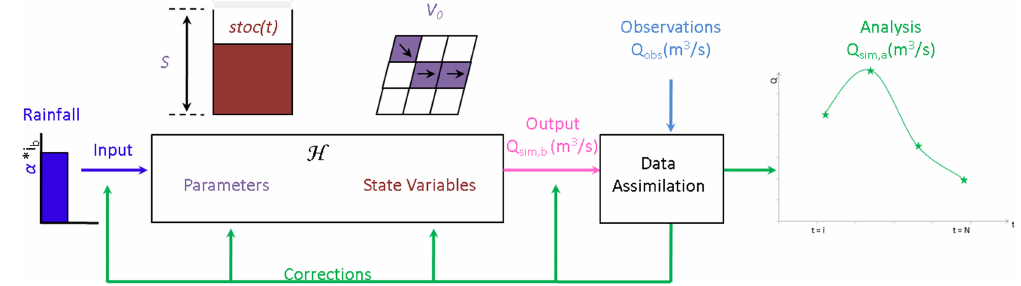
Fig. 4. Schematic representation of the hydrological model: inputs (blue), model parameters (purple), state variables (dark red) and the background model outputs ( Q sim,b in pink). Inputs, parameters, state variables or model outputs can be corrected by DA using observations ( Q obs in light blue) and model outputs in order to produce the corrected discharge ( Q sim,a in green).